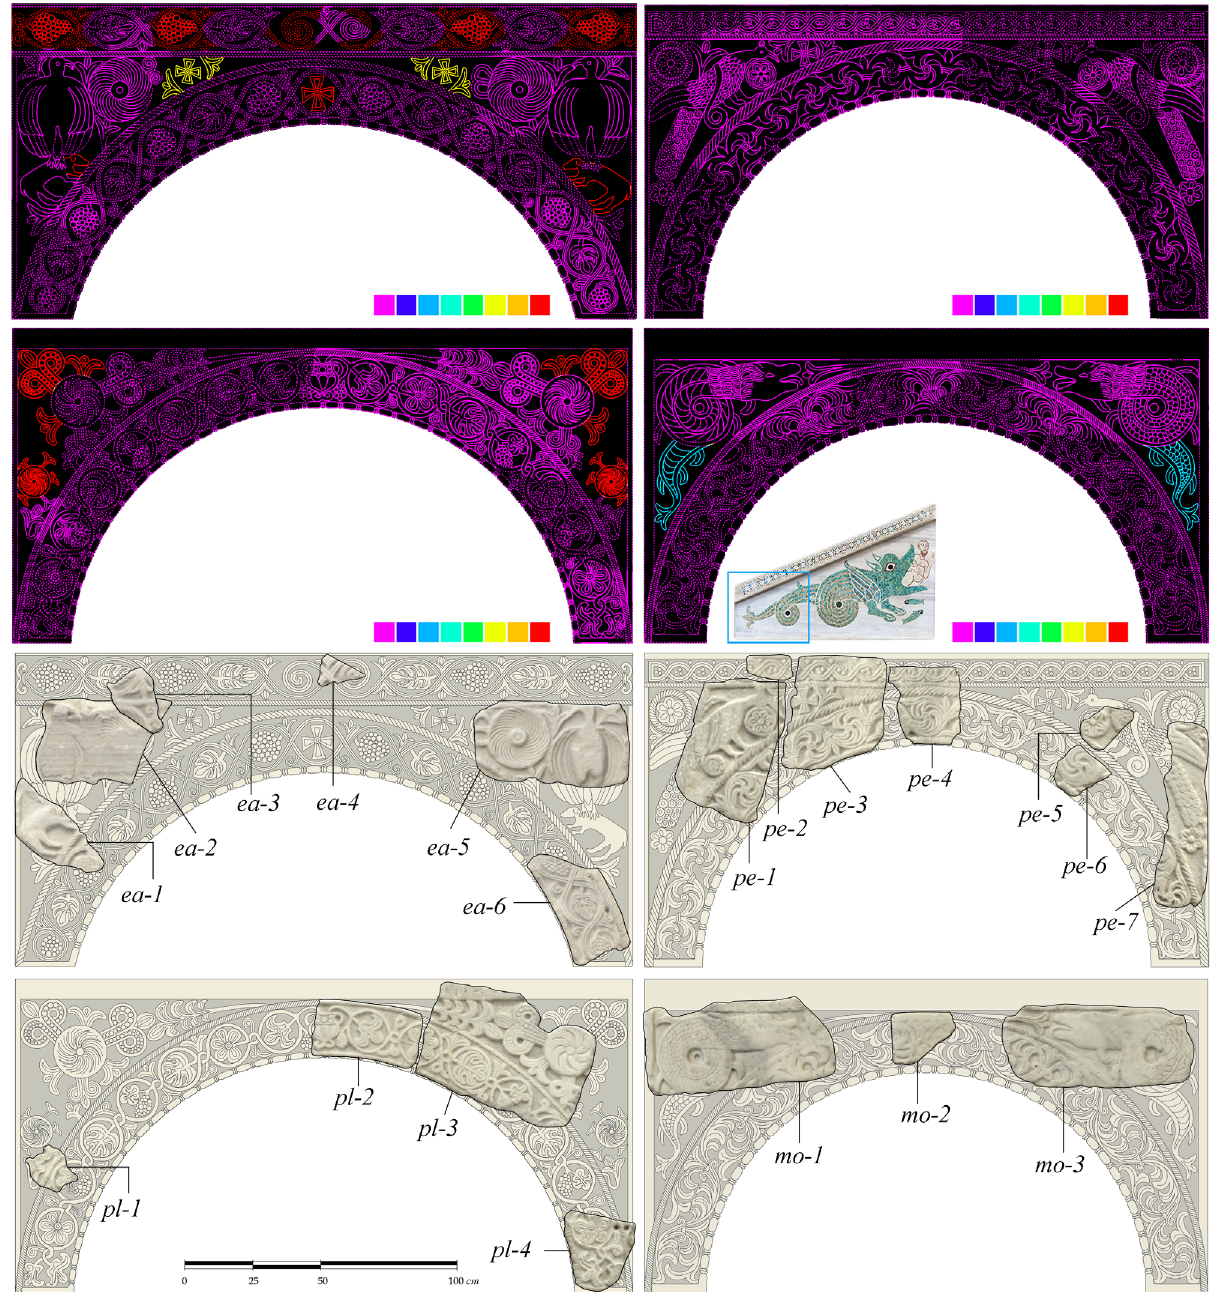
Figure 8. Uncertainty scale for reconstruction applied to 2D decorative elements of arcades; fragments integrated with